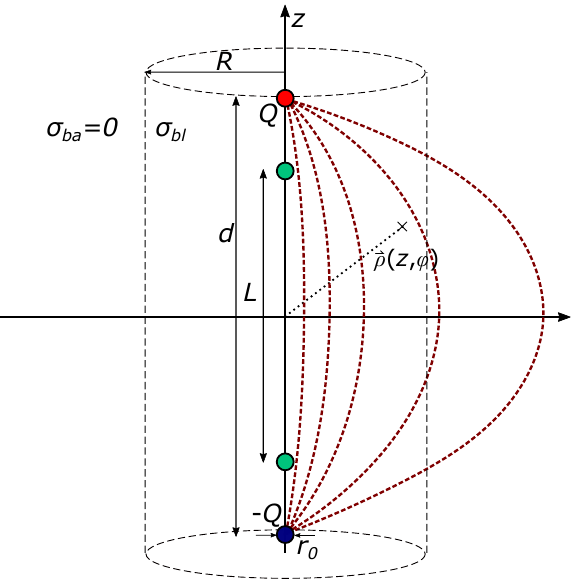
Figure 1: Electric field distribution of to spheres with op- posite charges Q (red) and (cid:0)Q (blue). The measurement electrodes (green) are distanced by L . Background tissue ( (cid:27) ) is assumed. ba = 0